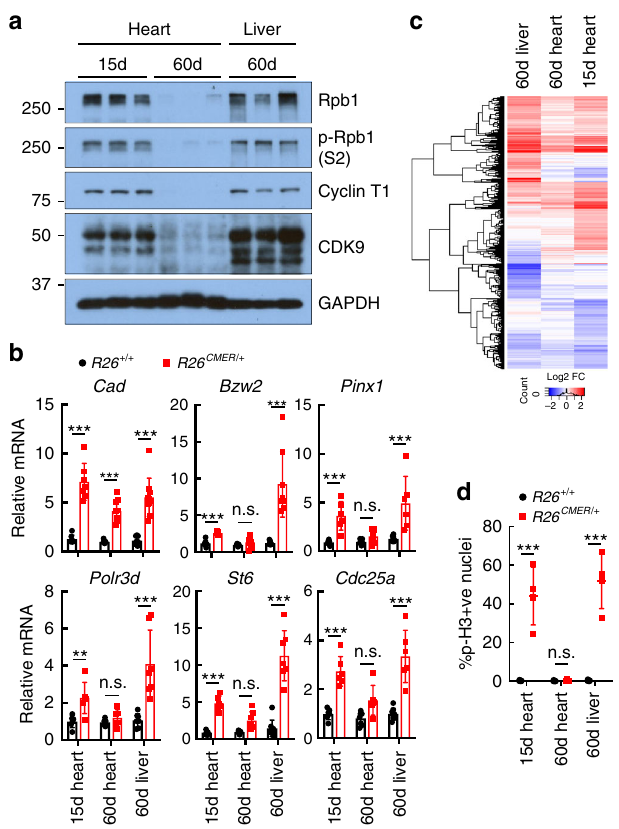
Fig. 6 The juvenile heart is permissive to Myc-driven transcriptional activation. a Immunoblot analysis of the C-terminal domain of RNA polymerase II, total (Rpb1) and phosphorylated (p-Rpb1(S2)), Cyclin T1 and CDK9 protein expression in wild-type heart and liver isolated from 15-day-old (15d) and 60-day-old (60d) mice. Replicate samples are derived from independent mice. b Quantitative RT-PCR analysis of Cad , Bzw2 , Pinx1 , Polr3d , St6 and Cdc25a expression in wild-type ( R26 + / + ) and R26 CMER/ + heart isolated from 15-day-old (15d, Bzw2 and Cad n = 6, Cdc25a , Pinx1 , Polr3d and St6 n = 7) mice vs heart ( Bzw2 , R26 + / + Pinx1 and R26 CMER/ + Cad n = 9,